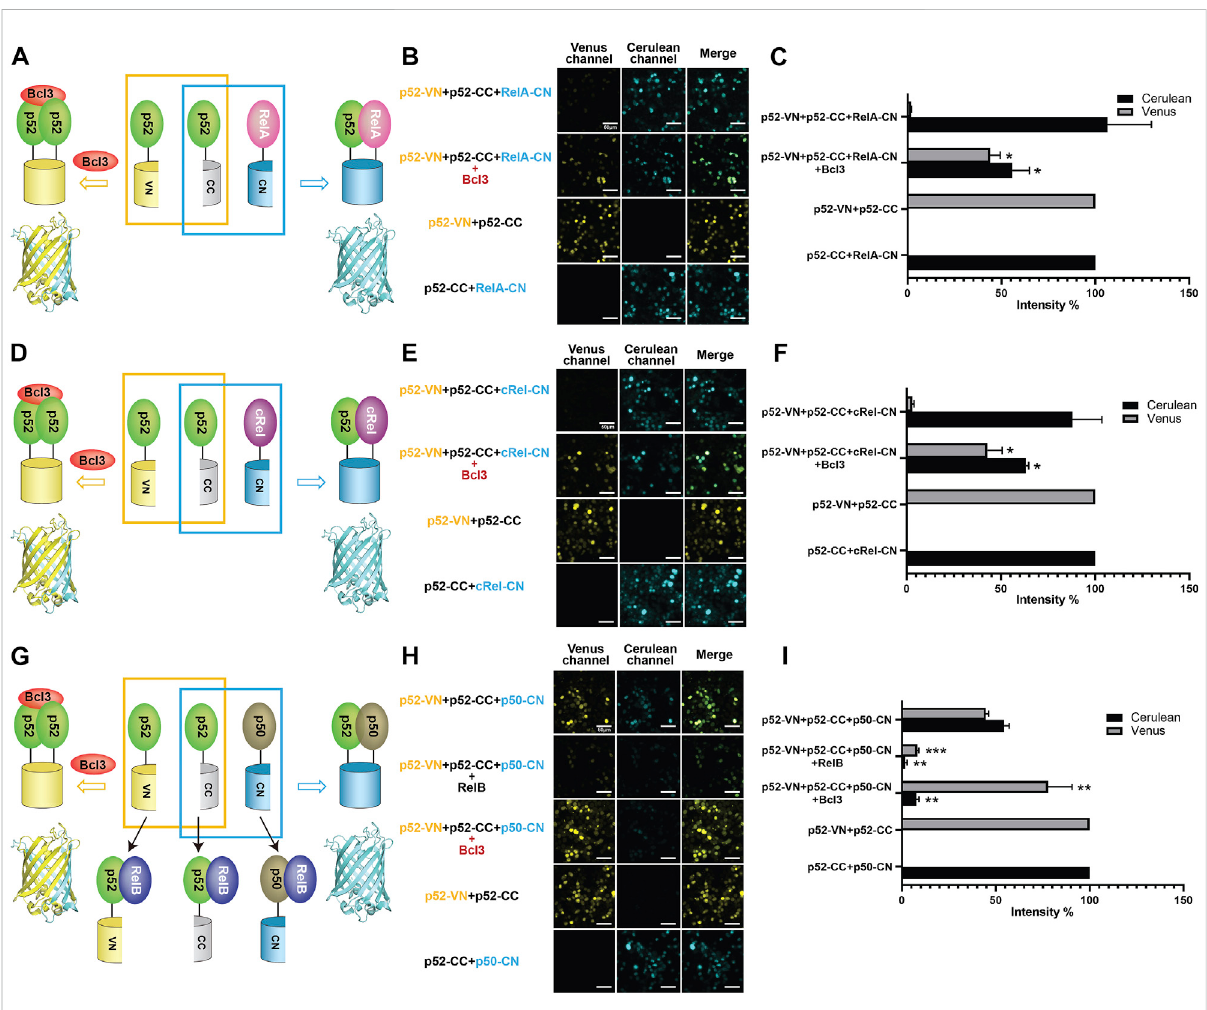
FIGURE 3 Bcl3 enhances the generation of the p52:p52 homodimer: p52:p52 vs. p52:RelA/p52:cRel/p52:p50. Diagrams illustrating the principle of multicolor BiFC assays: the p52:p52 homodimer formation bringsVN and CN together to form a fl uorescent protein whichcould be detected at the Venuschannel;the (A) p52:RelA, (D) p52:cRel,and (G) p52:p50heterodimerformationbringsCCandCNtogethertoformanintactCeruleanprotein whichcouldbedetectedusingtheCerulean channel.TheadditionofRelBwillheterodimerizewithp52orp50;therefore,bothp52:p52(Venus signal) and p52:p50 (Cerulean signal) will be decreased in (G) . Fluorescent images of (B) p52:p52 vs. p52:RelA, (E) p52:p52 vs. p52:cRel, and (H) p52: p52vs.p52:p50.TheadditionofBcl3enhancedp52:p52homodimerizationinallcases,asshownbytheenhancedVenussignals;theadditionofRelB decreased both p52:p52 (Venus) and p52:p50 (Cerulean) heterodimers in (H) . (C,F,I) Quanti fi cation of the fl uorescence intensity in (B) , (E) , and (H) . The fl uorescenceintensityofp52-VN+p52-CCwasdeterminedas100%forVenus,andthe fl uorescenceintensityofp52-CC+RelB-CN,p52-CC+ cRel-CN, or p52-CC + p50-CN wasdetermined as 100% for Cerulean. The data were analyzed from images ofthree independentexperiments.* p < 0.05; ** p < 0.01; *** p < 0.001 versus no Bcl3 or RelB co-expression ( t test). Error bars represent